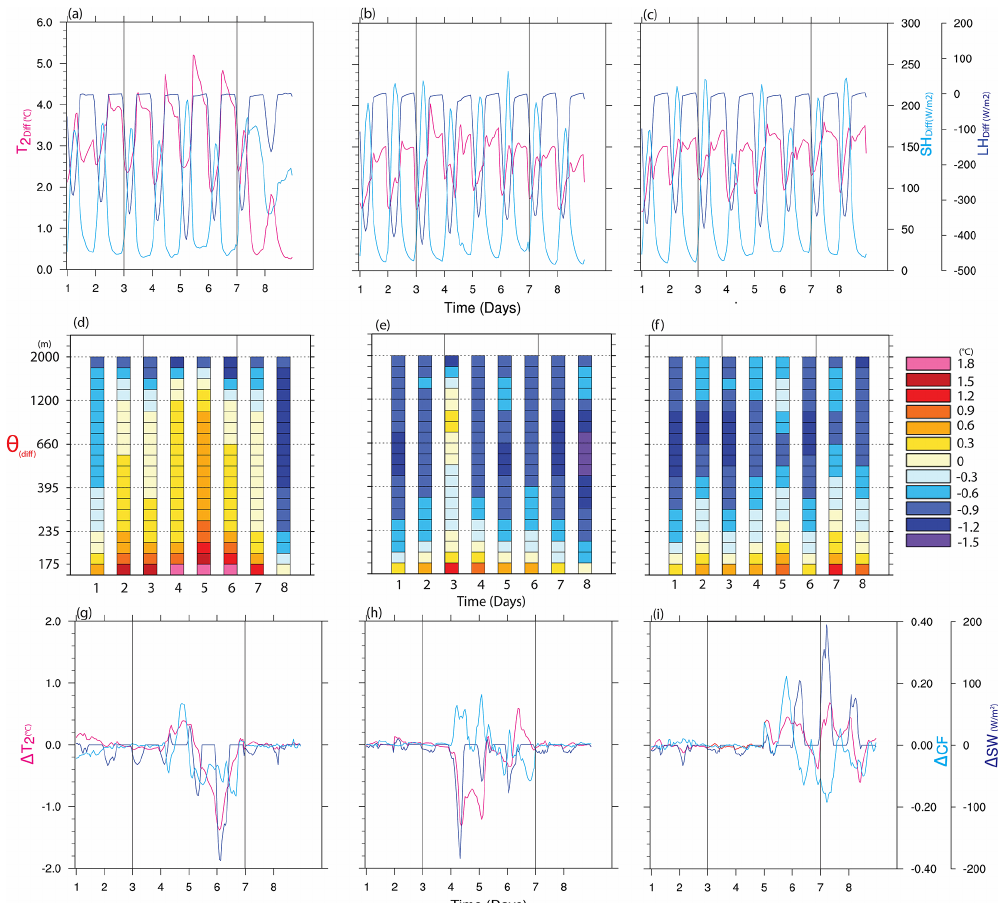
Figure 2. The model (CTRL) domain-averaged results showing (a–c) difference of T 2 ( T 2 ( diff ) ), sensible heat (SH; SH ( diff ) ), and latent heat (LH; LH ( diff ) ) between urban and vegetated grids for TC-HPE rep , ST-HPE rep and HY-HPE rep ; (d–f) vertical profile of potential temperature difference θ ( θ ( diff ) ) for TC-HPE rep , ST-HPE rep and HY-HPE rep at midday for the PRD region; (g–i) the changes of T 2 ( (cid:49)T 2 ), CF ( (cid:49) CF) and incoming shortwave radiation SW ( (cid:49) SW) at the surface induced by total aerosol radiative forcing for TC-HPE rep , ST-HPE rep and HY-HPE rep